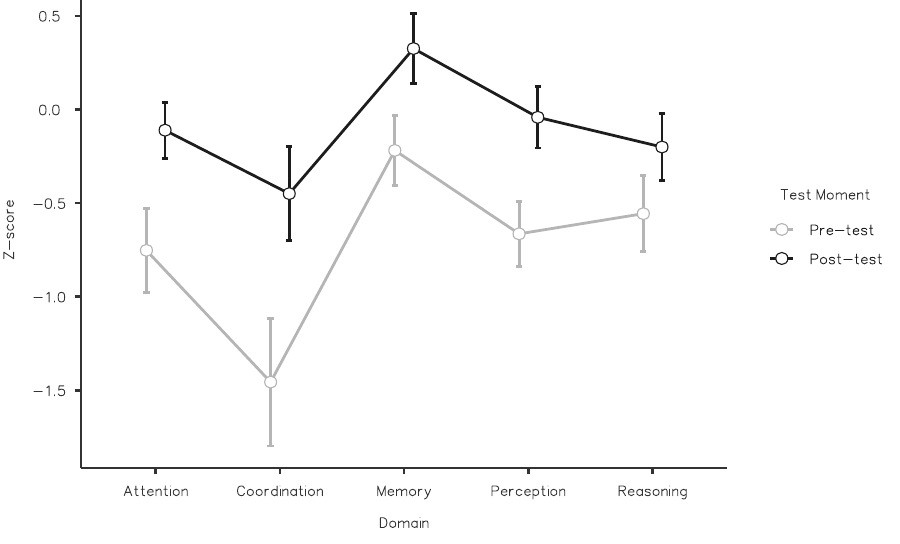
Figure 1. Factorial analysis of z-scores. Error bars correspond to the 95% confidence intervals.